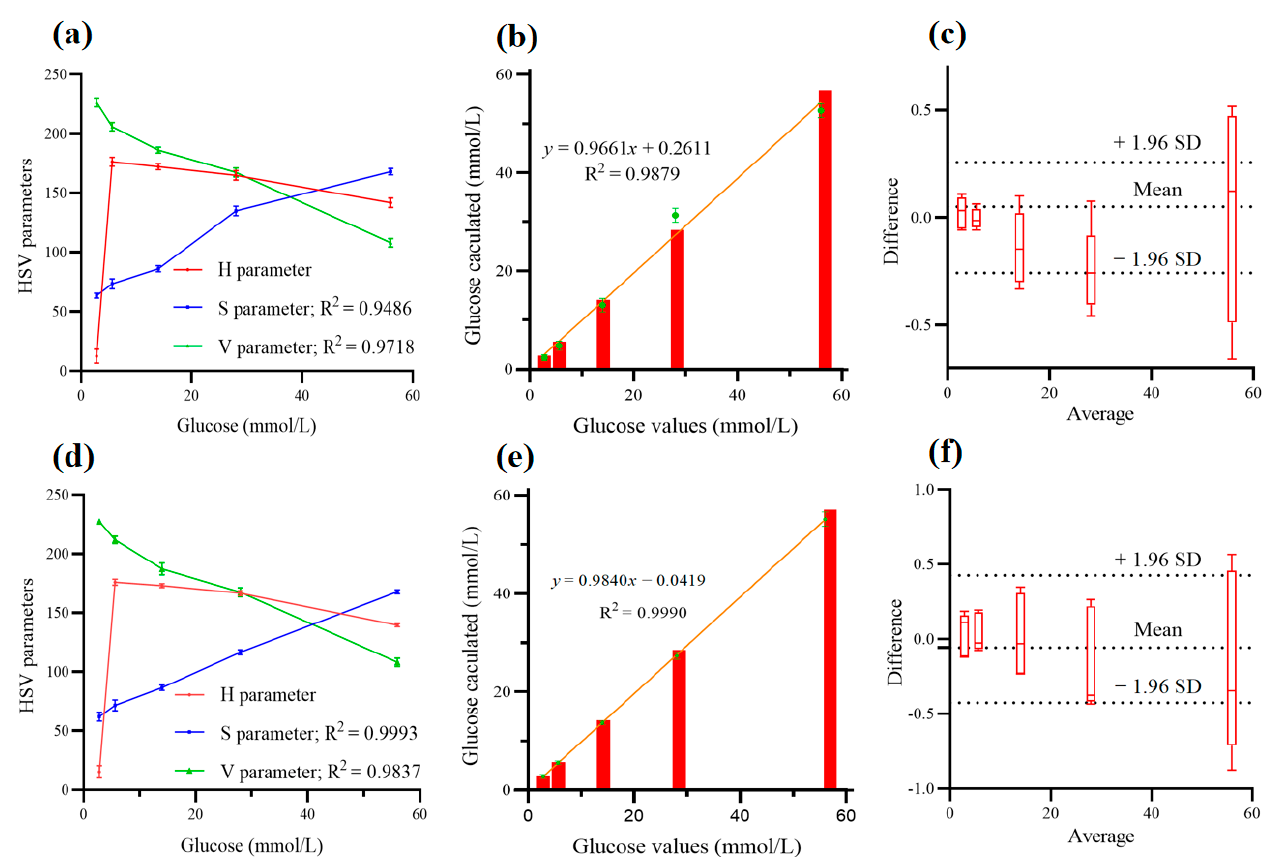
Figure 4. Comparison of results before and after the algorithm process. ( a , d ) HSV parameters vs. glucose. ( b , e ) Glucose concentration was analyzed using the proposed method and the glucose oxidase method. The horizontal coordinates represent the true values of the glucose concentration, and the vertical coordinates represent the values measured by the POCT device. ( c , f ) B&A plots based on colorimetric analysis and GOD.